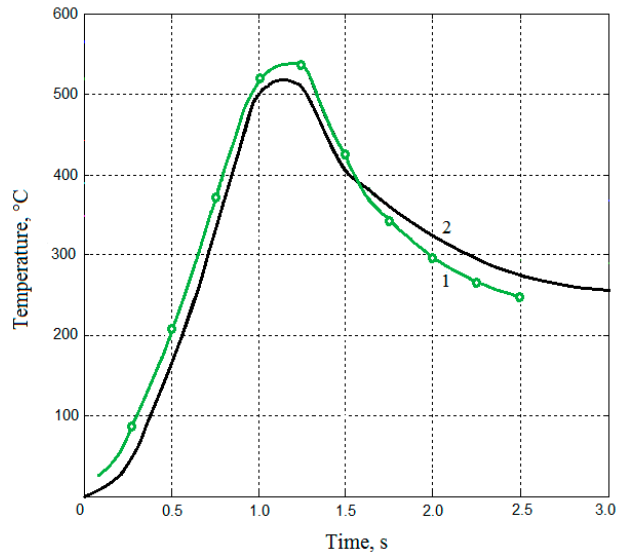
Figure 4. Temperature spread in a workpiece over grinding time.